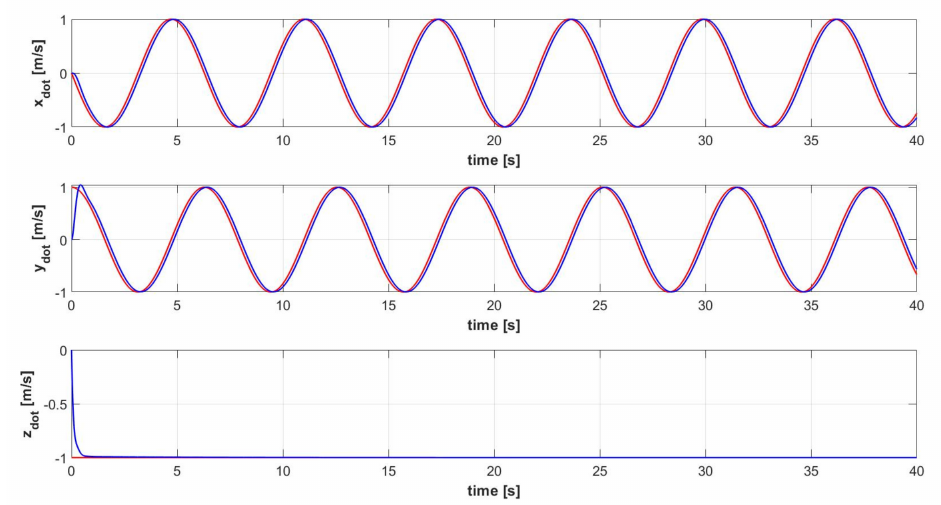
Figure 9. Velocity signals [X (cid:48) ( t ) , Y (cid:48) ( t ) , Z (cid:48) ( t ) ] of the controlled quadrotor system (blue) and reference velocity signals of trajectory 1 (red).